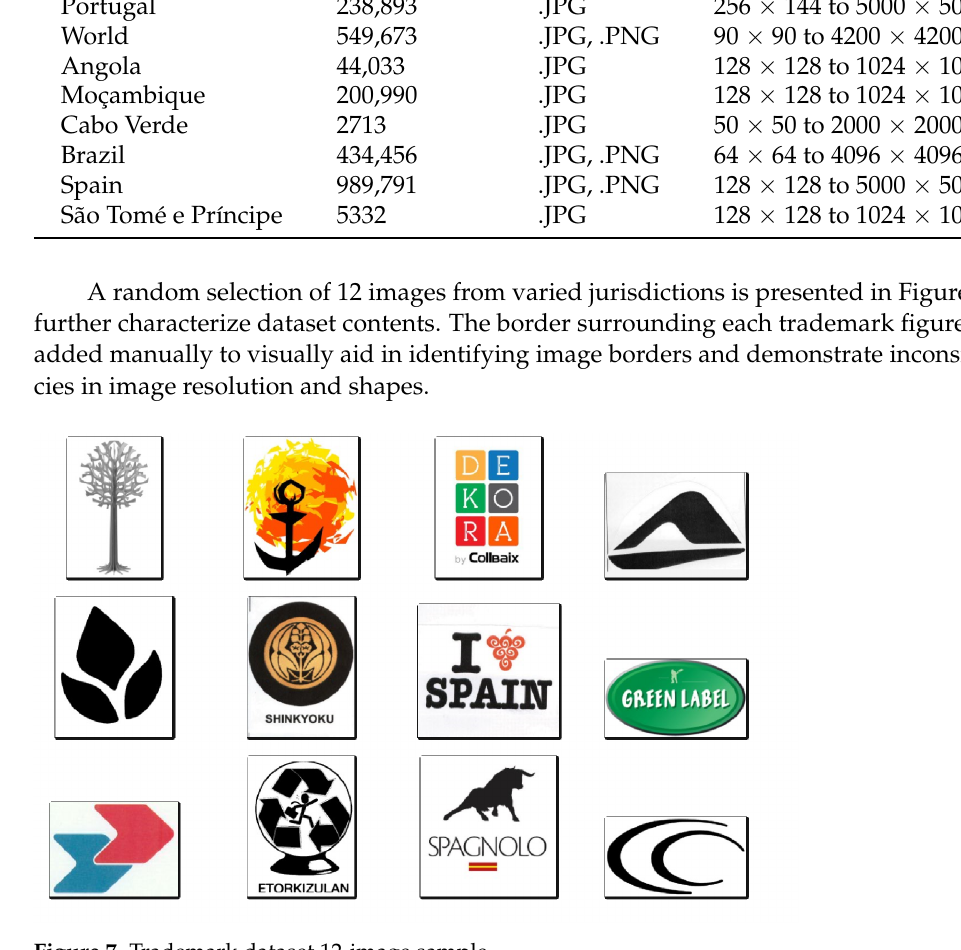
Figure 7. Trademark dataset 12-image